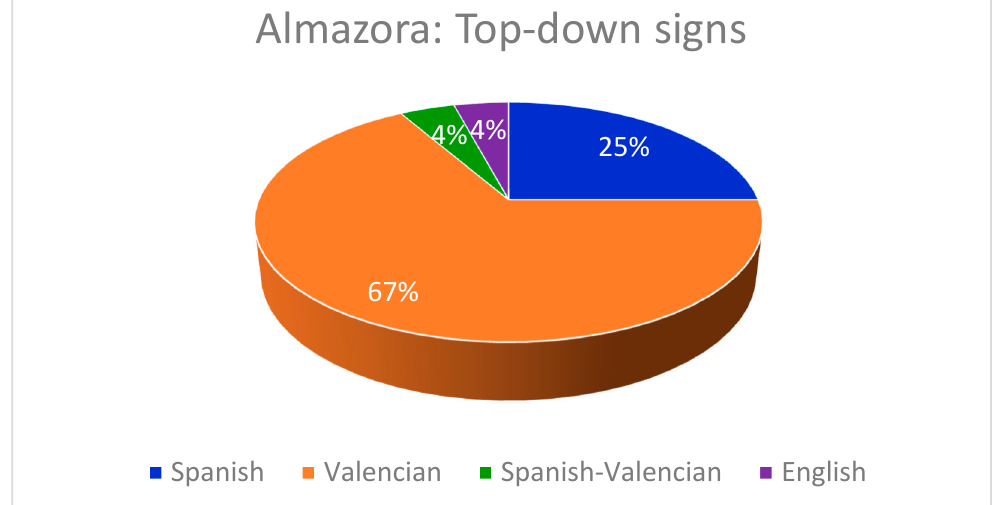
Figure 12. Almazora: Top-down signs .